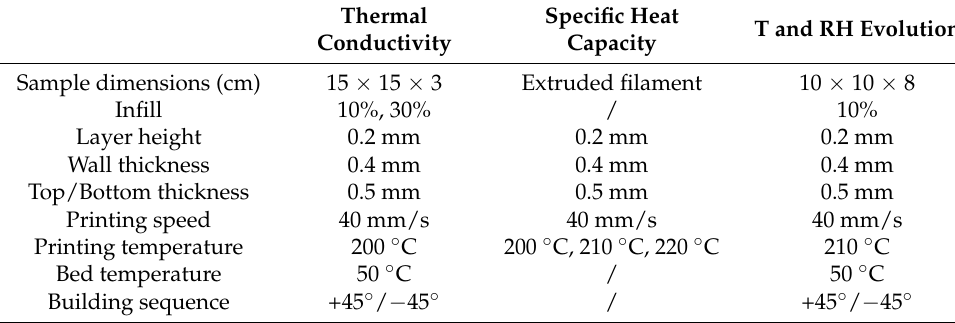
Table 2. Printing parameters used for the experimental characterisation campaign.